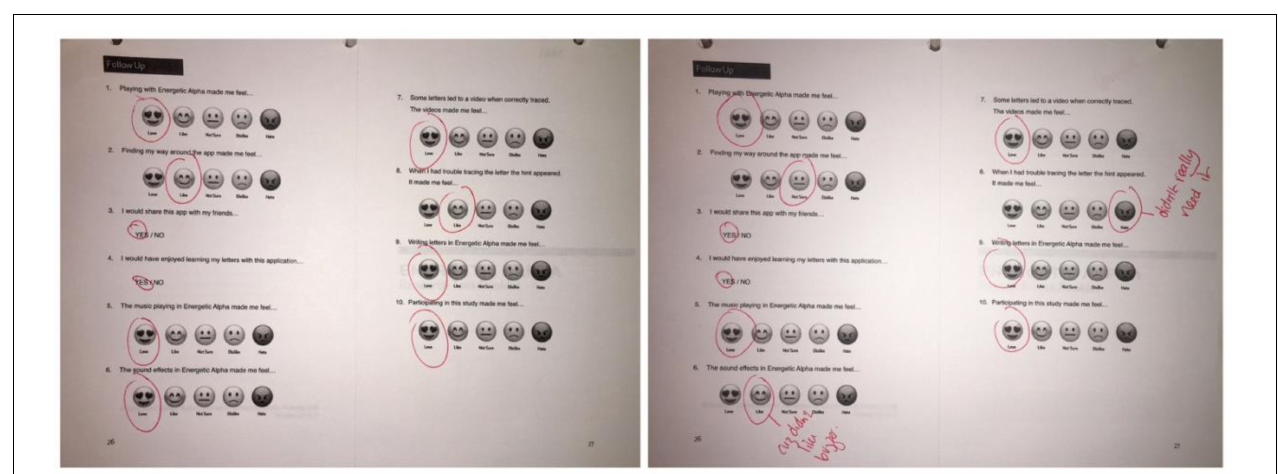
FIGURE 6 | The animation comparison chart from the task booklet with notations from testing.